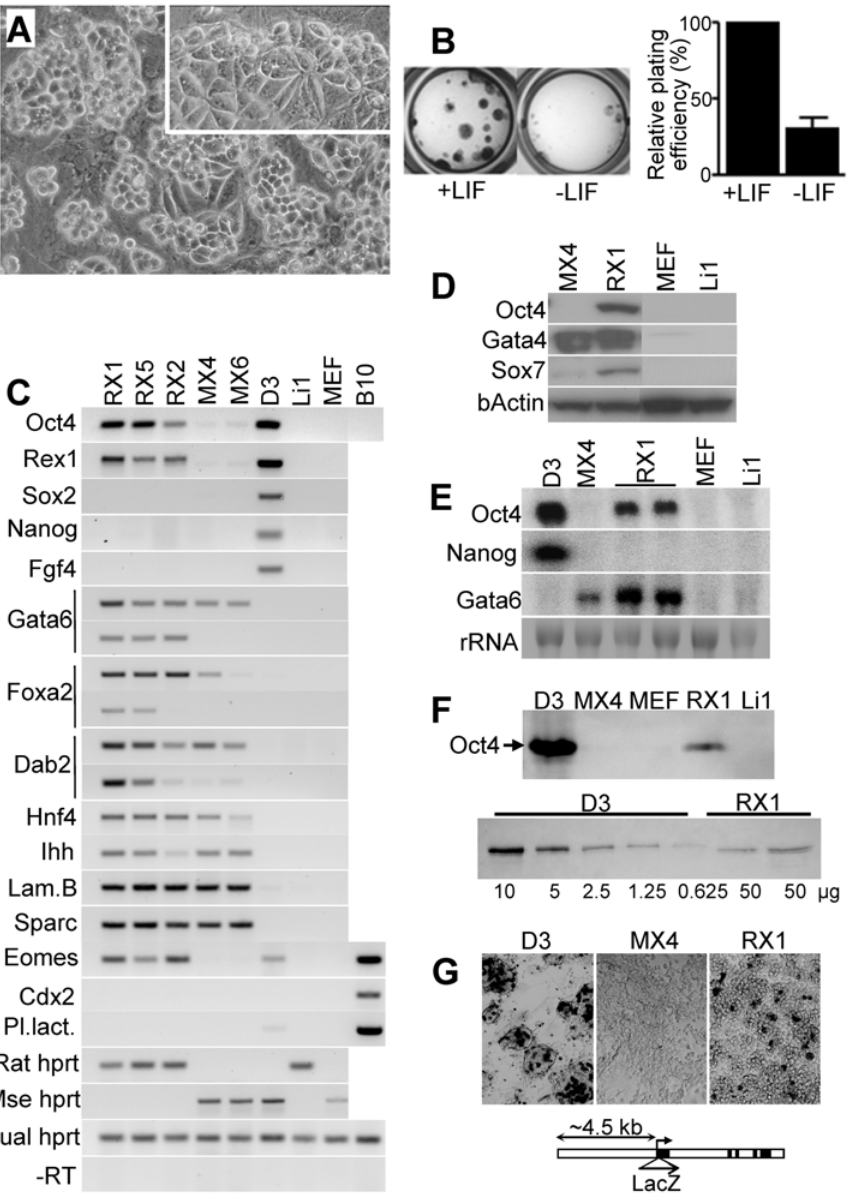
Figure 2. Growth behavior and comparative embryonic lineage marker analysis of rat XEN-P cell lines. ( A ) Phase contrast photo showing characteristic morphology of rat XEN-P cell lines growing on rat embryo fibroblast feeder. Colonies obtained by low-density plating typically contained round, refractile cells at their fringes and epithelial cells inside (inset). ( B ) Representative photos illustrating that LIF (1000 u/ml) increased colony diameter and frequency (crystal violet staining) (line RX1). Similar results were obtained with line RX2 (strain BDIX). ( C ) RT-PCR analysis showing that rat XEN-P cell lines exhibit a mixed embryonic lineage marker profile. Rat XEN-P cell lines (RX1, RX2, RX5) were compared with mouse XEN cell lines (MX4, MX6), a mouse ES cell line (D3), a trophectoderm-like rat cell line (B10), a rat embryo fibroblast cell line (Li1) used as feeder for the XEN-P cell lines, and primary mouse embryo fibroblasts (MEF) used as feeders for mouse XEN and ES cells. Lines D3 and B10 have been described before [43,13]. 2 m g of RNA per sample were reverse-transcribed or not (-RT), followed by PCR using dual-specific (rat=mouse) primers. For Gata6, Foxa2, and Dab2, two dilutions of the RT reaction were subjected to PCR for semi-quantitative comparison. ( D ) Western blot analysis of XEN-P (RX1), mouse XEN (MX4), and feeder (MEF, Li1) cell lines. 40 m g of cell protein were loaded per lane. ( E ) Northern blot analysis of XEN-P (RX1), mouse XEN (MX4), mouse ES (D3), and feeder (MEF, Li1) cell lines. 5 m g of total RNA were loaded per lane. ( F ) Western blot analysis for Oct4 in rat XEN-P (RX1), mouse XEN (MX4), mouse ES (D3), and feeder (MEF, Li1) cell lines, using a monoclonal anti-Oct4 antibody. 50 m g (top) or the indicated amounts (bottom) of cell protein were loaded. RX1 samples from two passages (P39, P40) were analyzed (bottom). Similar results were obtained with a polyclonal antibody (not shown). ( G ) Transient expression of mouse Oct4 gene-based LacZ reporter gene GOF9 [53] by rat XEN-P and mouse ES but not mouse XEN cell lines. Histochemical stainings of lines D3, MX4, and RX1 (similar results were obtained with line RX2). Non-transfected cells did not show LacZ staining (not shown). When comparing the frequencies of reporter gene expression in mouse ES vs. rat XEN-P cell lines, keep in mind that only a subpopulation in the rat cell lines highly expresses the endogenous Oct4 gene (Fig. 3).